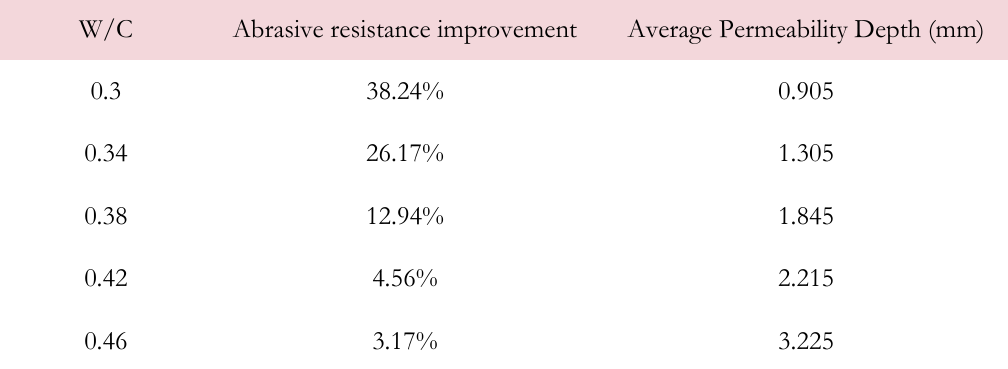
Table 3: Abrasion resistance improvement and average permeability depth for various values of water-cement